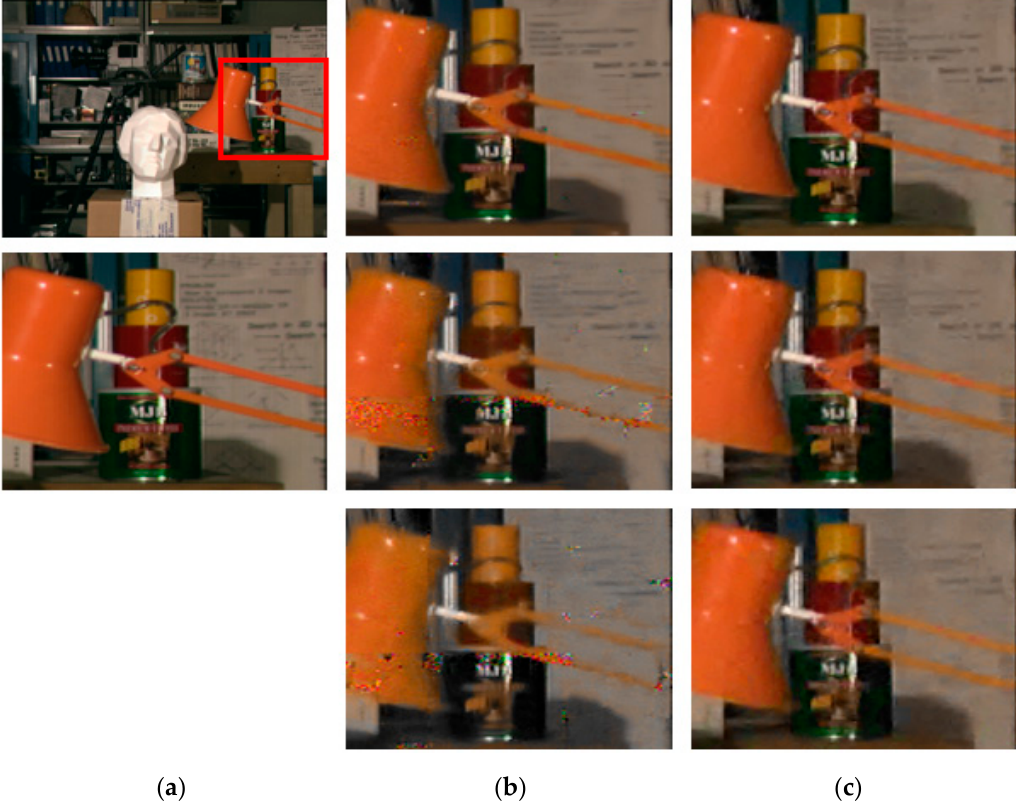
Figure 7. Subjective quality of Ohta. ( a ) Original image; ( b ) LFBM5D when sigma = 15, 25 and 35; ( c ) proposed when sigma = 15, 25 and 35.